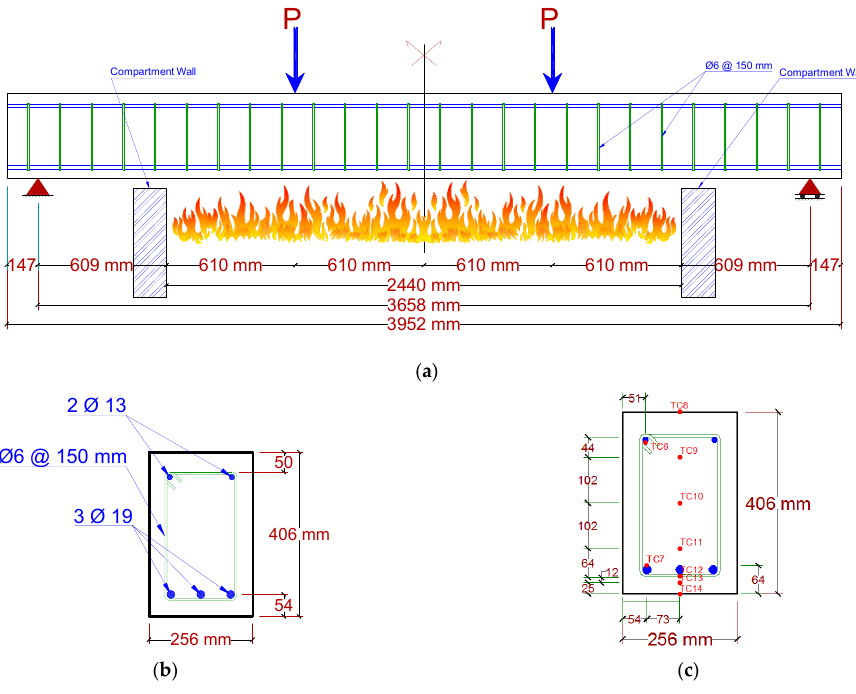
Figure 1. Beam Configuration: ( a ) Elevation, ( b ) Cross ‐ section, and ( c ) Location of thermocouples at mid ‐ section [21].